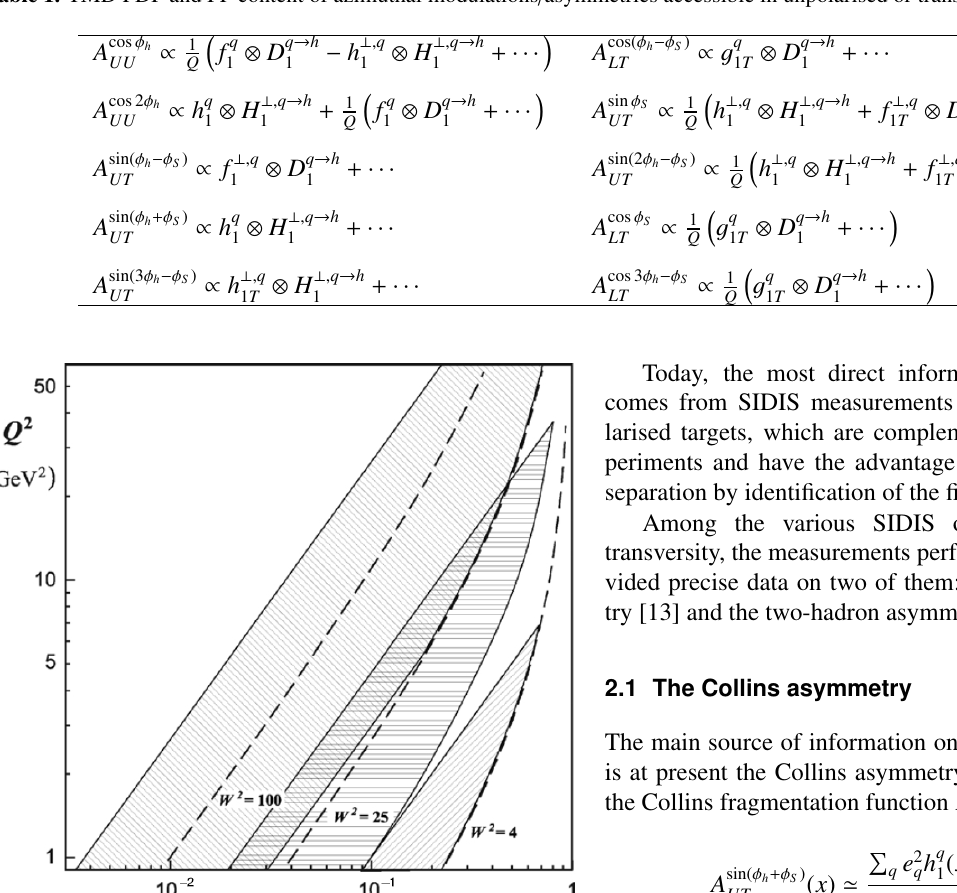
Table 1. TMD PDF and FF content of azimuthal modulations / asymmetries accessible in unpolarised or transversely polarised SIDIS